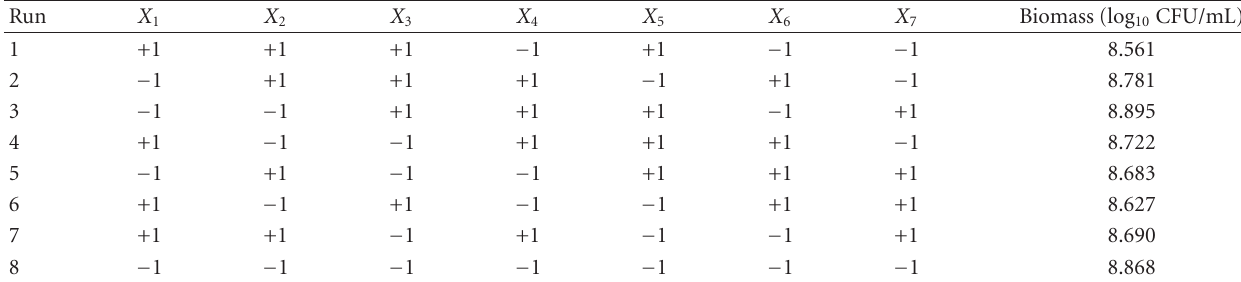
Table 3: Experimental design and results of the Plackett-Burman